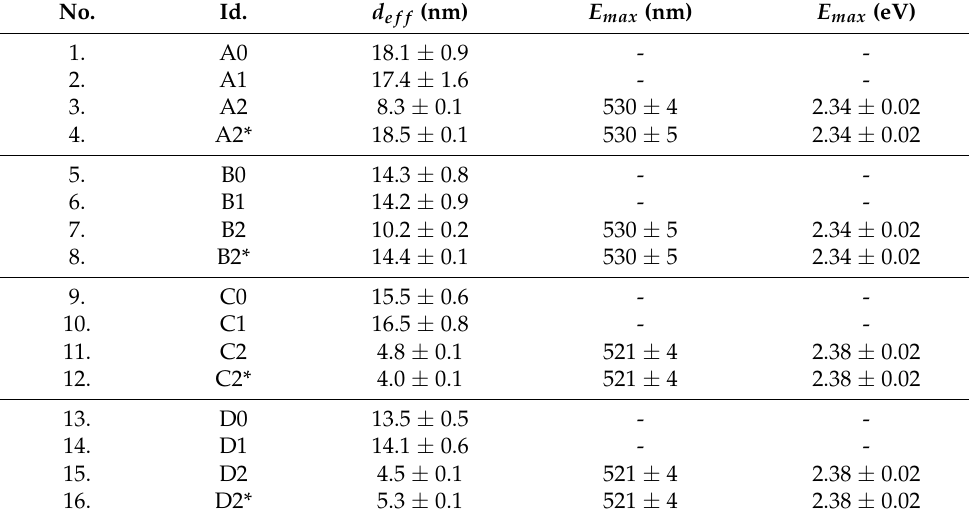
Table 2. The effective thickness ( d ef f ) and the energy of the absorption peaks ( E max ). No.